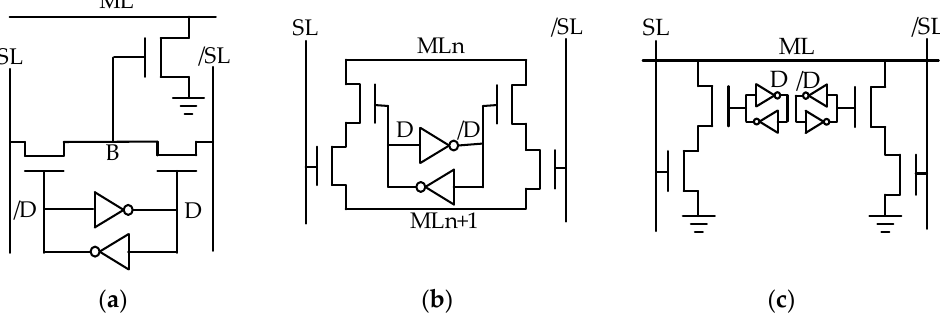
Figure 2. CAM cell structure: ( a ) 9-T binary CAM (BCAM); ( b ) 10-T BCAM; and ( c ) 17-T ternary CAM (TCAM) [7].